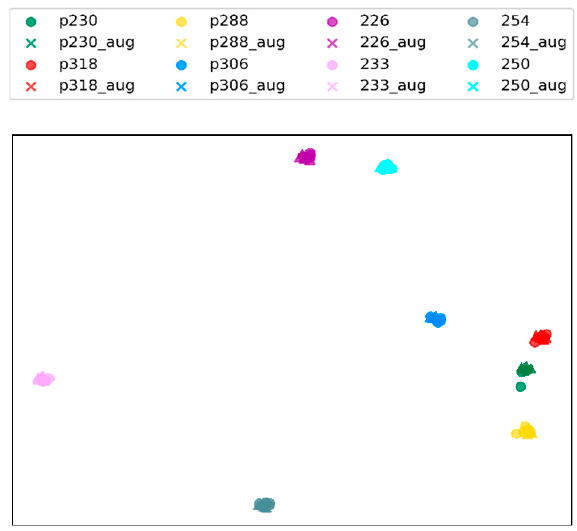
Figure 5. Speaker embedding clustering visualization.